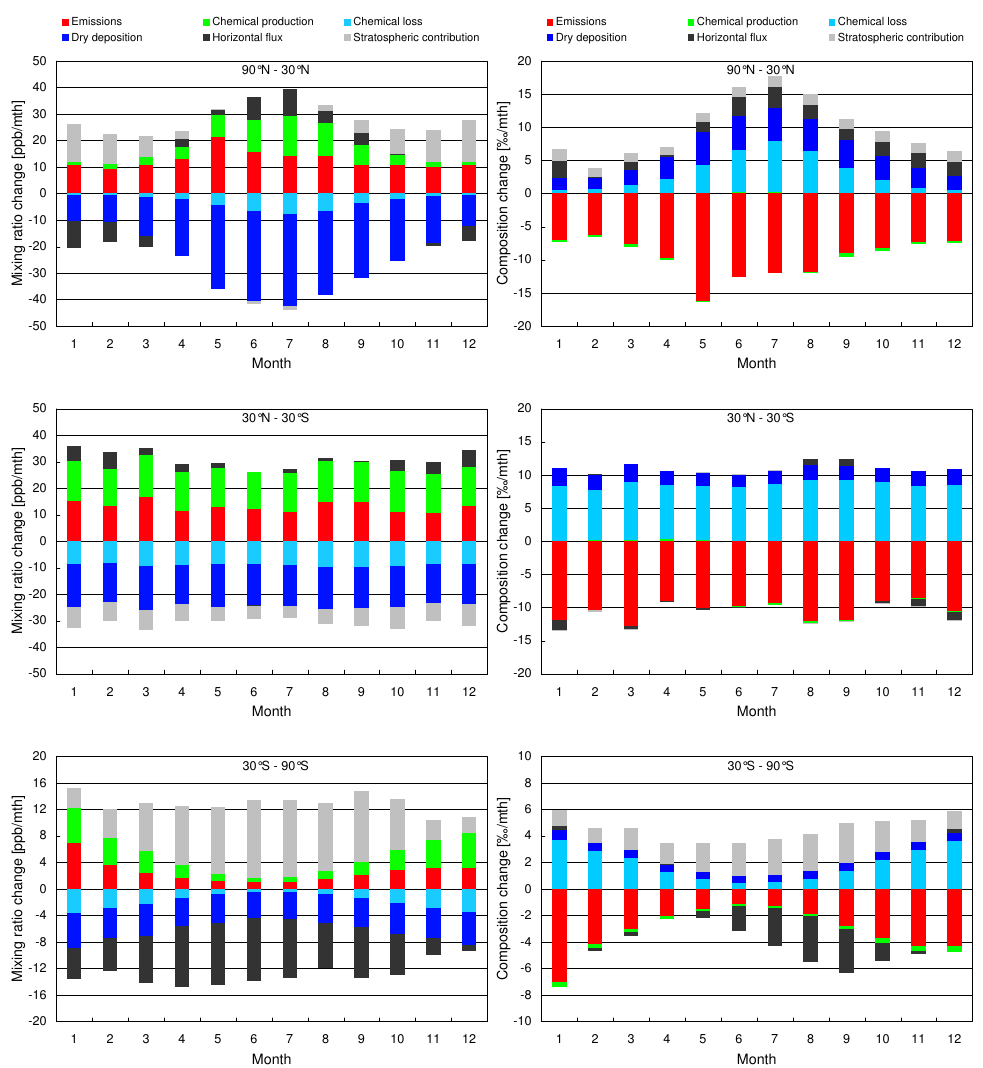
Fig. 8. The modelled contributions of the different processes to monthly changes in the mixing ratio (left column) and isotopic composition (right column) in Fig. 7, derived from the budgets of the latitude bands from 90 ◦ N to 30 ◦ N, 30 ◦ N to 30 ◦ S, and 30 ◦ S to 90 ◦